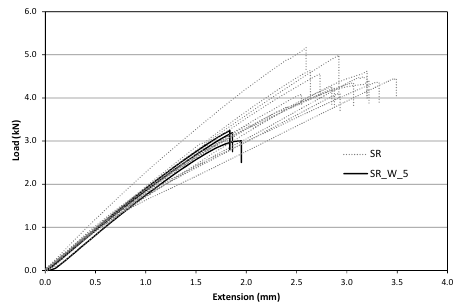
Figure 11. Comparison between SR and SR_SW_3.